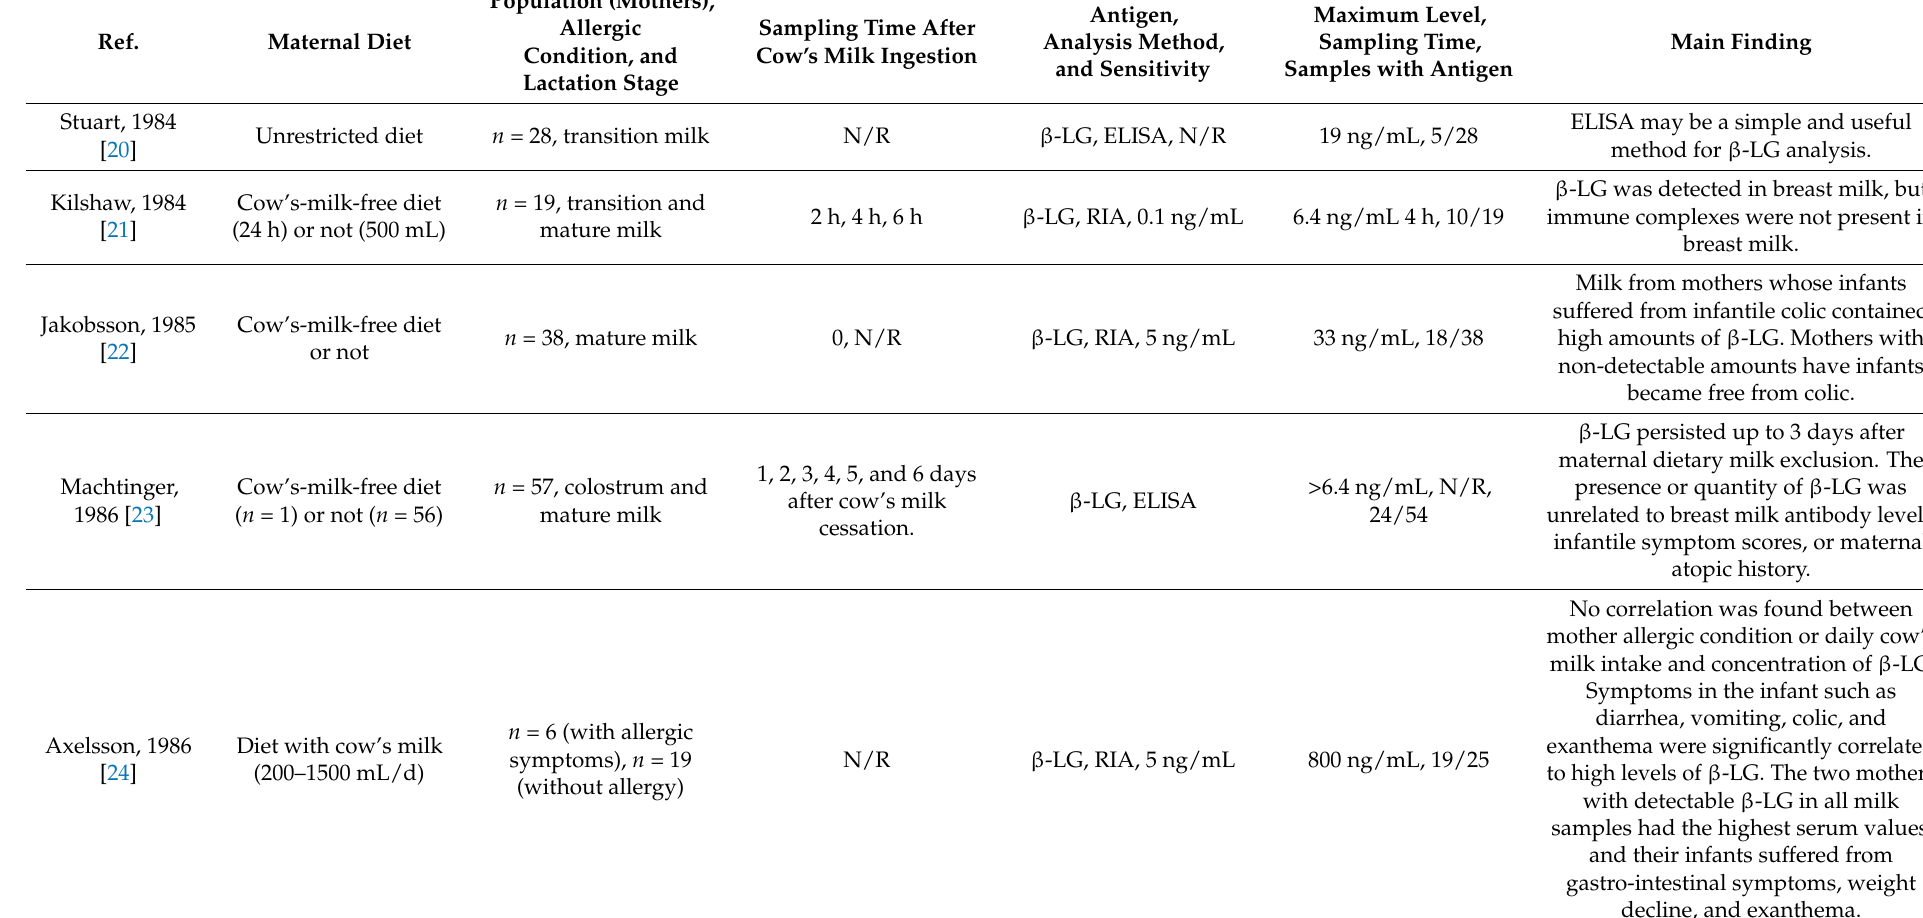
Table 1. Characteristics and findings of studies evaluating the presence of cow’s milk allergens in breast milk ( n = 27).